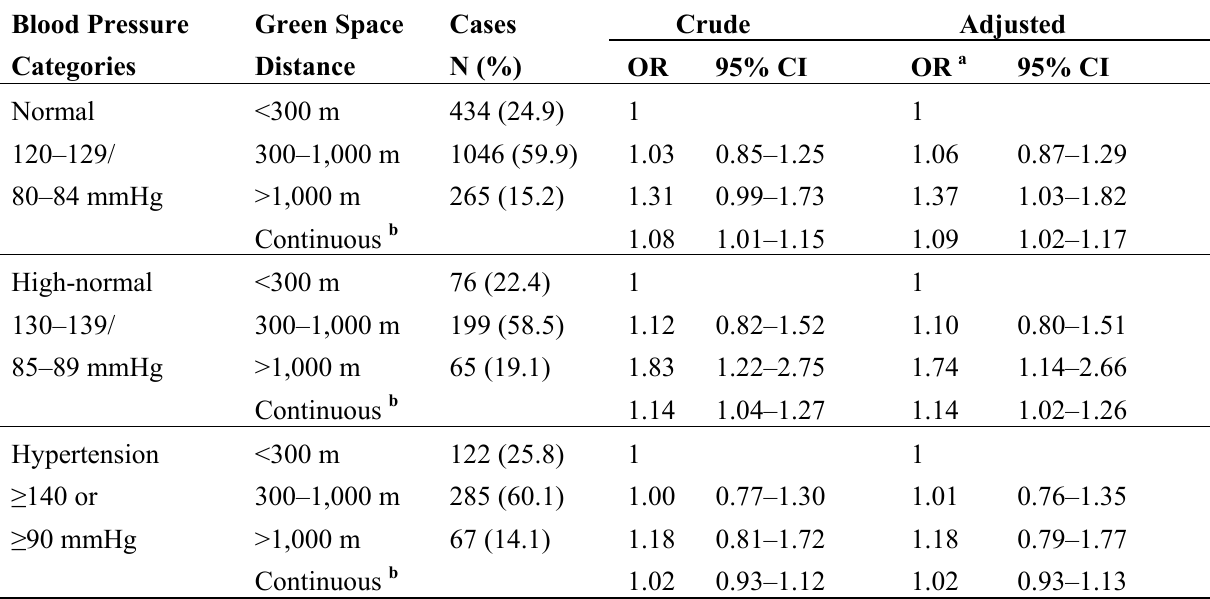
Table 3. Crude and adjusted odds ratios (OR) and 95% confidence intervals (CI) for increased blood pressure according the proximity to city